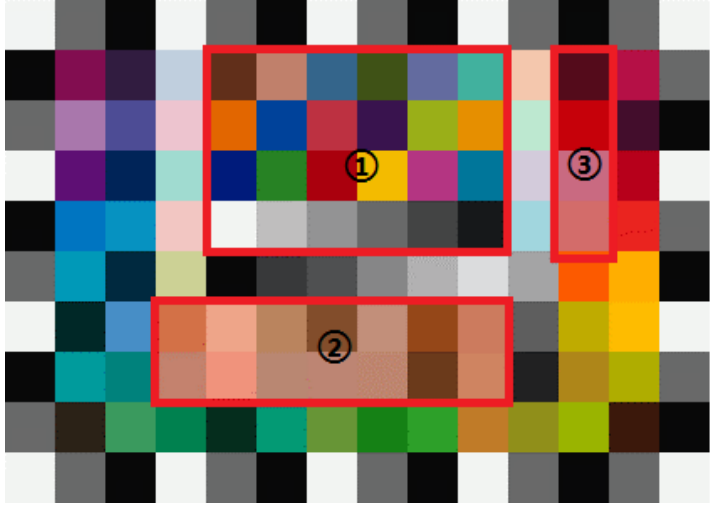
Figure 5. The color area of interest.